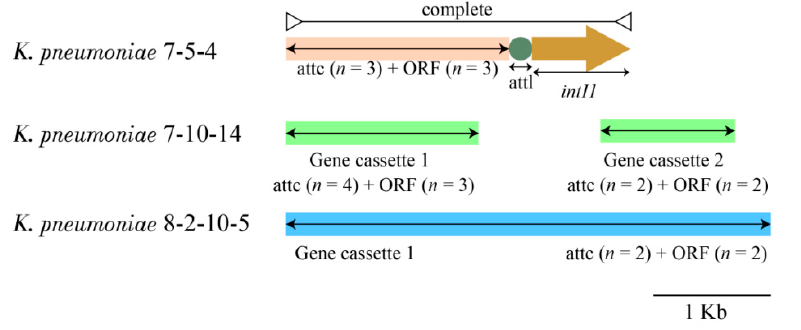
Figure 5. The structure diagram of the INs identi fi ed in the K. pneumoniae genomes.